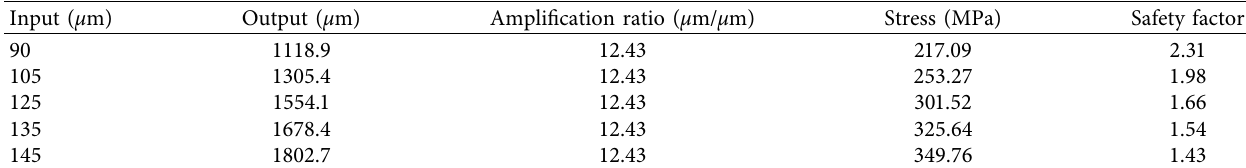
Figure 5: Proposed hybrid displacement amplifer: (a) 3D, (b) 2D, (c) meshing, (d) mesh quality. Table 2: Results of amplifcation ratio of proposed